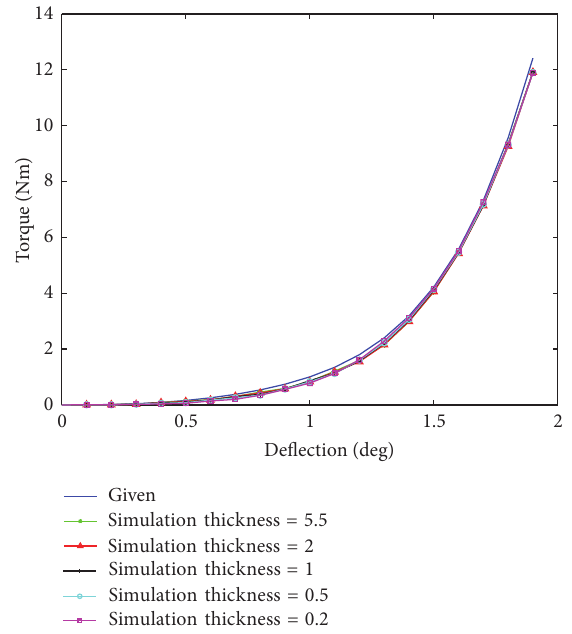
Figure 5: The torque-deflection trajectory with different thick-